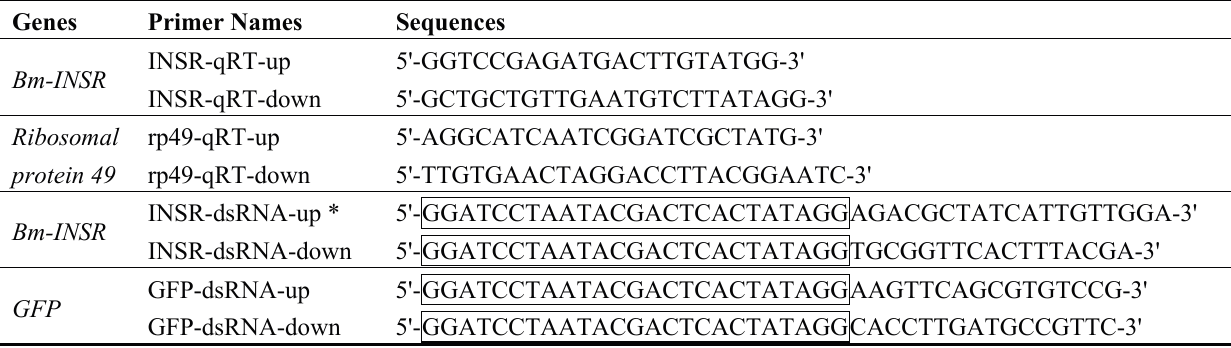
Table 2. The silkworm orthologs of human genes associated with diabetes